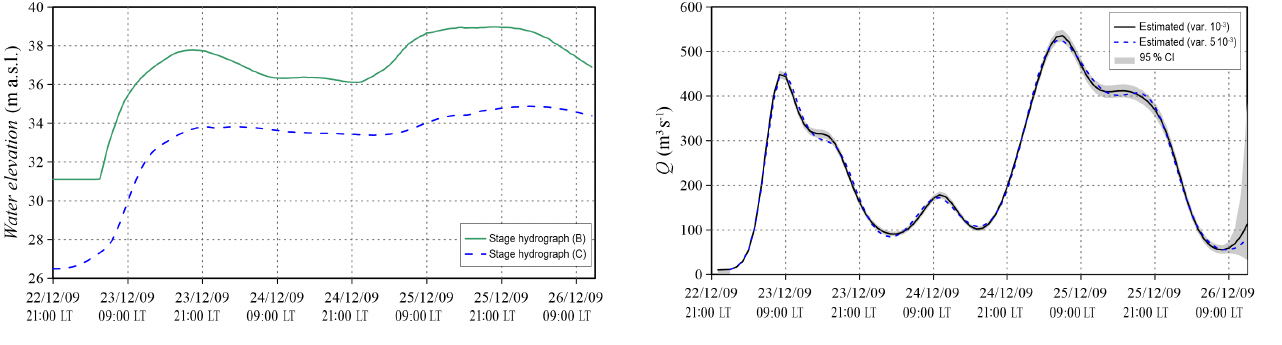
Figure 16. Secchia 2009 event: estimated inflow hydrographs as- suming the epistemic error variance equal to 10 − 3 m 2 and 5 × 10 − 3 m 2 . The 95% credibility interval applies to the simulation with the epistemic variance equal to 10 − 3 m 2 .